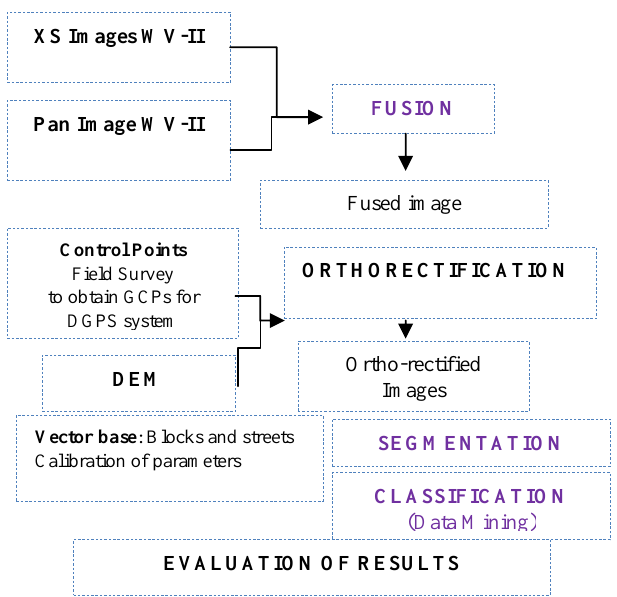
Figure 4 – Methodological